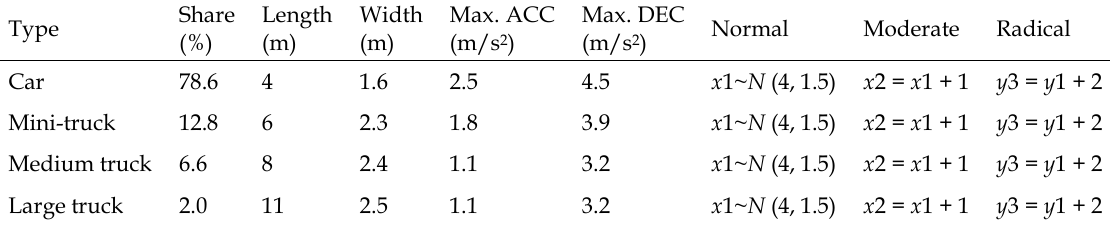
Overview of vehicle attributes and driving behavior in the